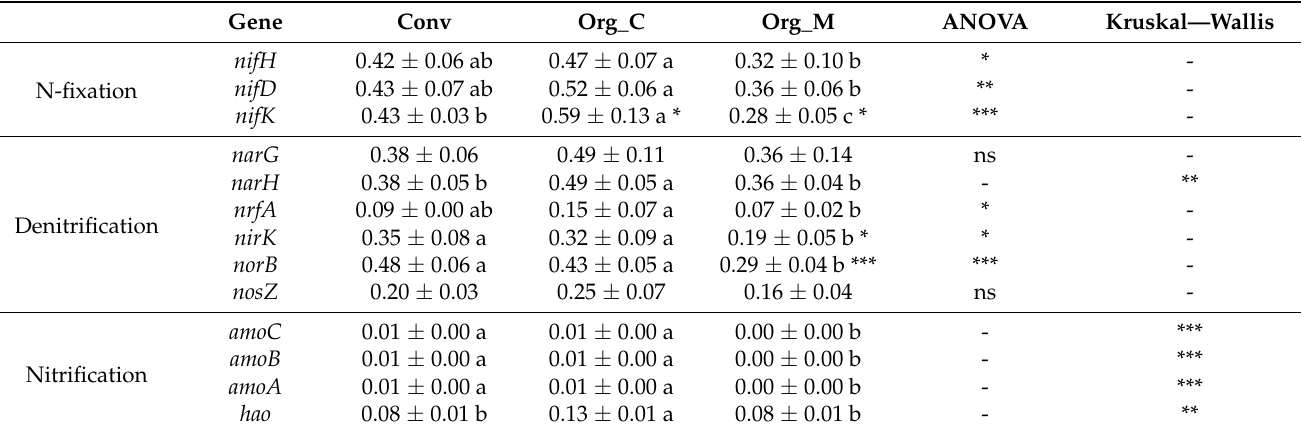
Table 2. Predicted N gene count for the most abundant N cycling genes detected in three crop- ping systems.